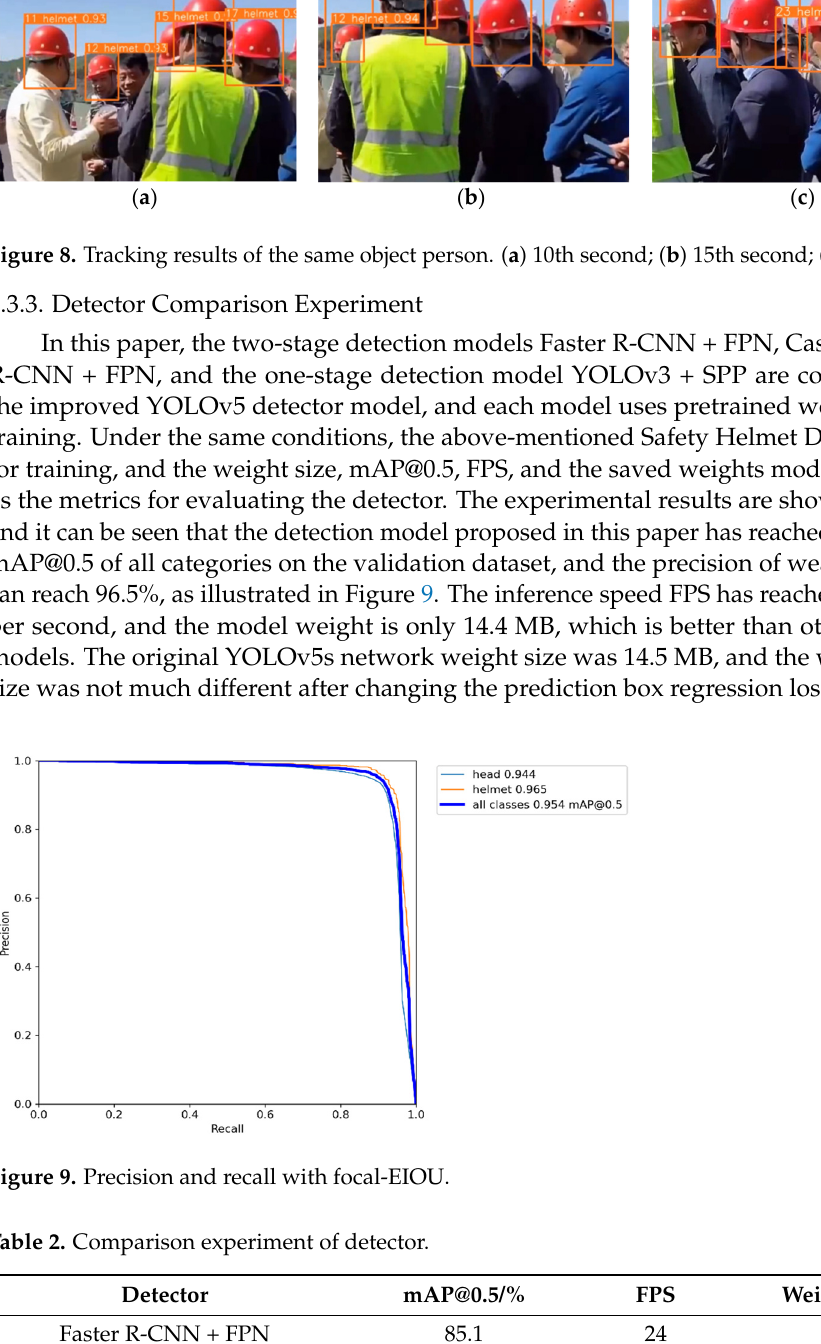
Table 3. Comparison of FPS.